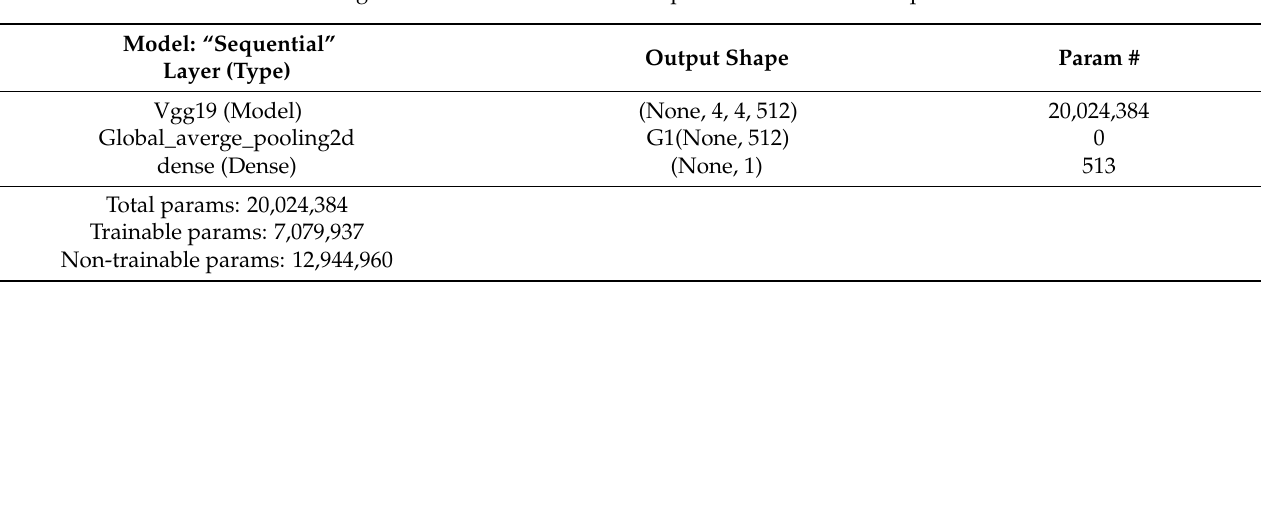
Table 8. Configuration details and number of parameters. Model: